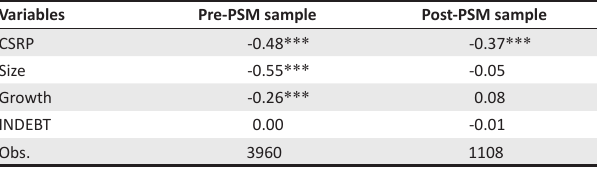
TABLE 3: Pre- and post-matching control variable balance across firms with independent boards and without independent boards.